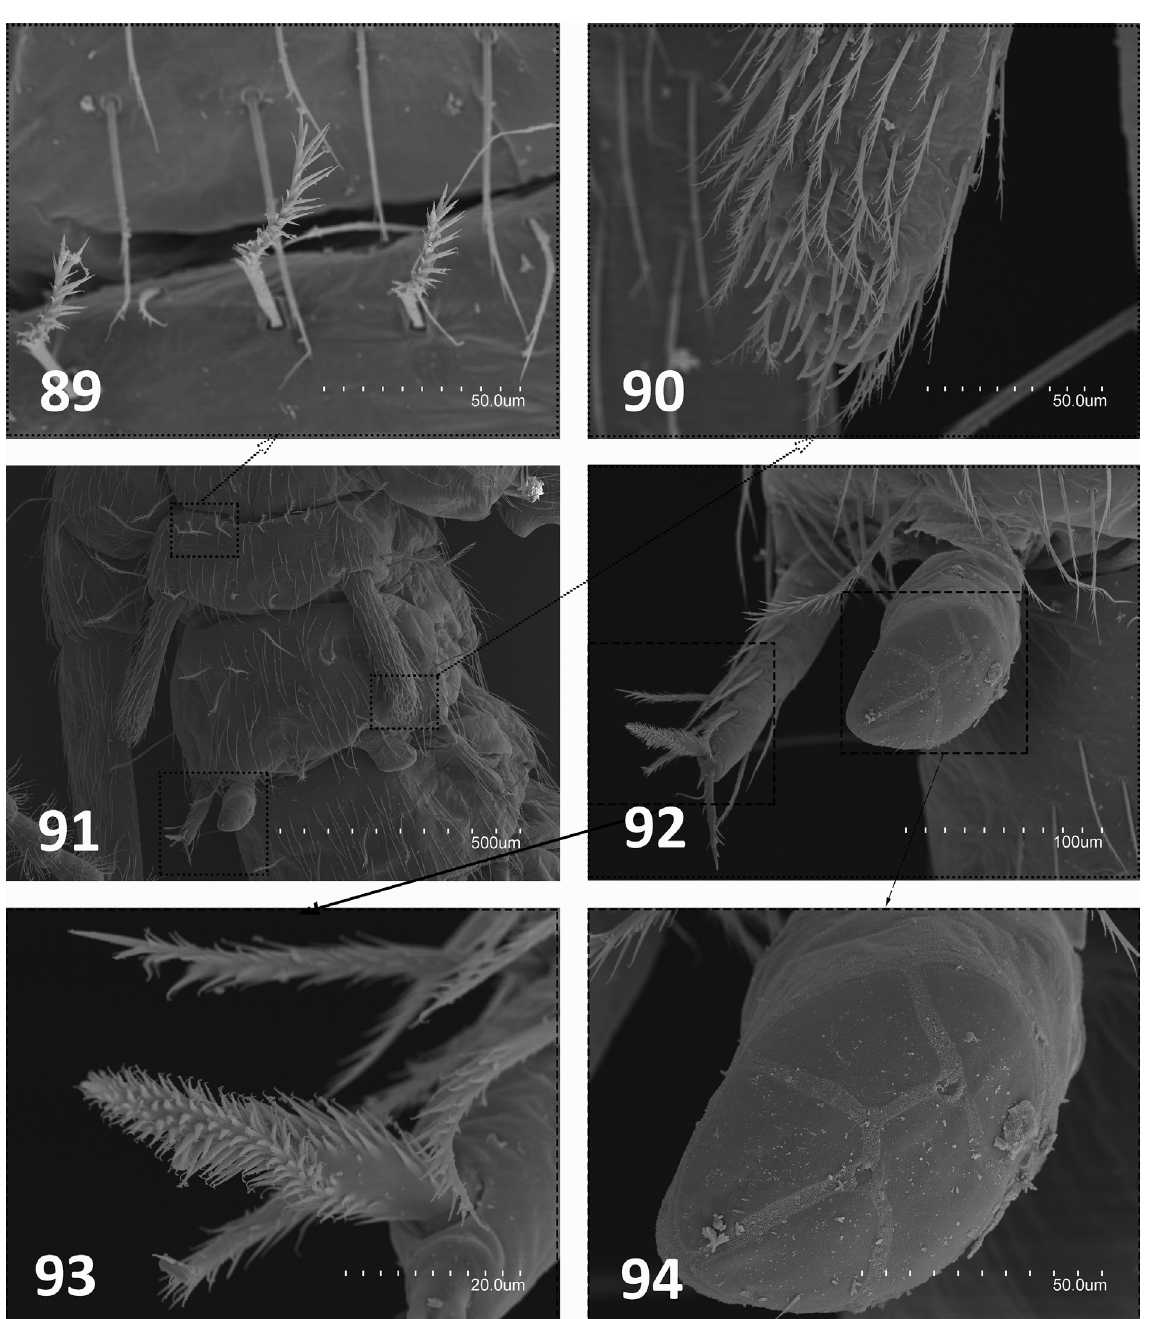
Figs 89–94. Plusiocampa ( Plusiocampa ) hoffmanni Sendra & Paragamian sp. nov., ♀, from Varathro Stou Bokou ton Poro, Krousonas, Crete (Coll. AS). 89 . Macrosetae on anterior portion of urosternite I. 90 . Distal portion of an appendage on urosternite I. 91 . Urosternites I–II. 92 . Stylus and abdominal eversible vesicle. 93 . Detail of a stylus with subapical seta. 94 . Abdominal eversible vesicle,